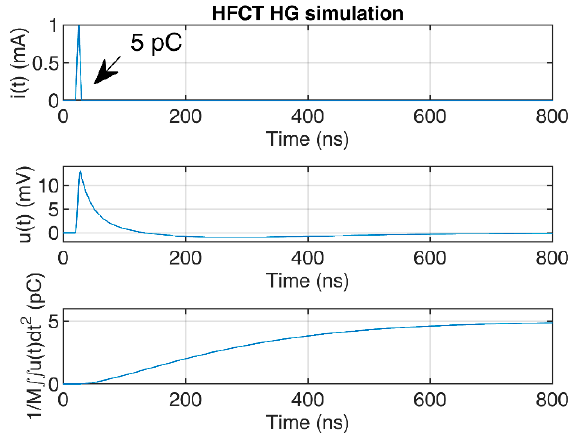
Figure 8. HFCT_HG sensor response and charge estimation of a 5 pC and 10 ns triangular current pulse.